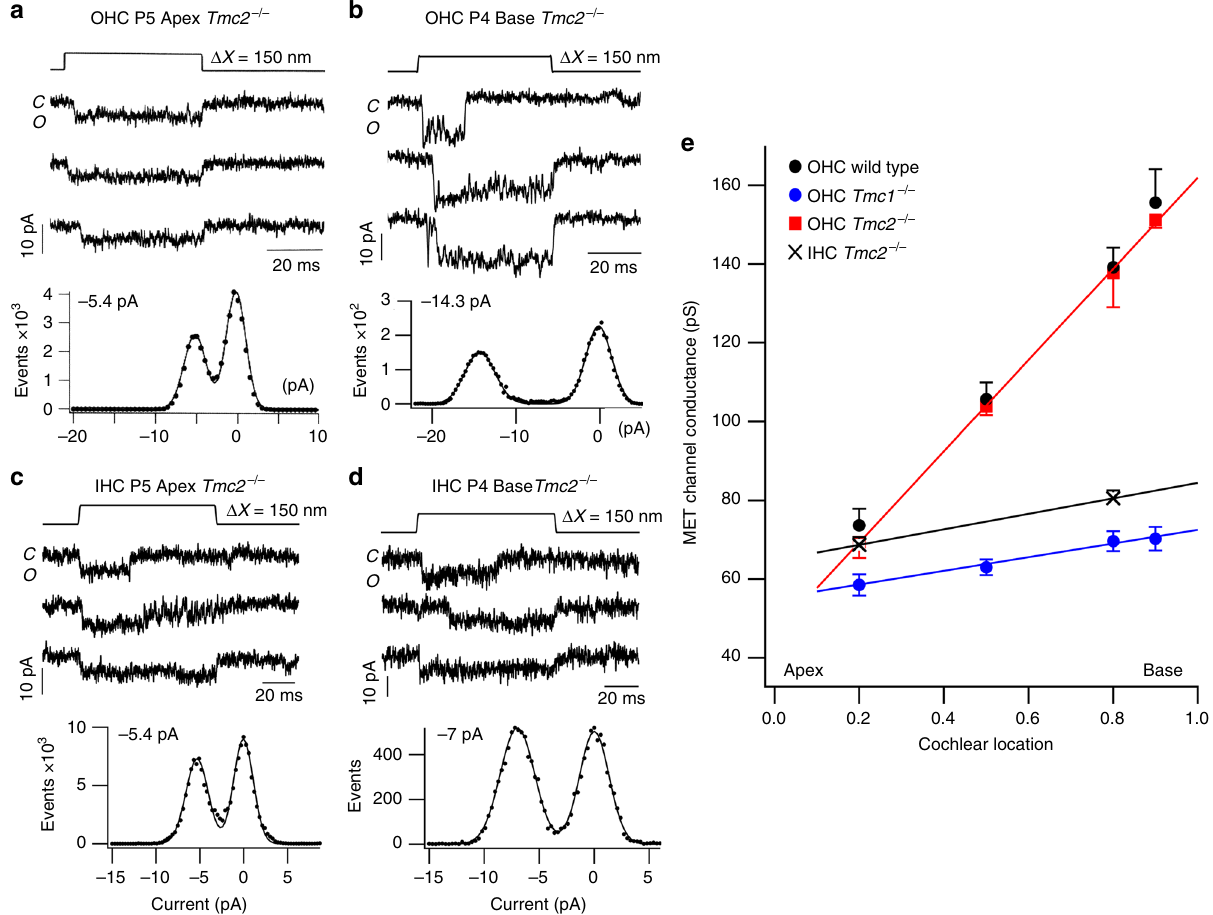
Fig. 2 Tonotopic organization of MET channels. a Three examples of single-channel currents in response to hair bundle de fl ection (top) in P5 apical Tmc2 − / − mice. Amplitude histogram of events gives − 5.4 pA single-channel current. b Three examples of single-channel currents in P4 basal OHC; amplitude histogram of events gives − 14.3 pA single-channel current. Holding potential − 84 mV. c Three examples of single-channel currents evoked in apical IHC of P5 Tmc2 − / − mice. Amplitude histogram of events gives 5.4 pA single-channel current. d Three examples of single-channel currents in P4 basal IHC; amplitude histogram of events gives 6.9 pA single-channel current. Holding potential − 84 mV. e Collected results on MET channel conductance plotted against fractional distance along the cochlea from the apex, for OHCs of P3 – P7 wild-type (black symbols), Tmc2 − / − mice (red symbols), and Tmc1 − / − mice (blue symbols) and for Tmc2 − / − mouse IHCs (black crosses). Each point is the mean ± SEM; numbers of cells, apex to base: OHC wild type, 14, 4,14, 7; OHC Tmc2 − / − 11, 4, 10, 3; OHC Tmc1 − / − 18, 3, 14, 3; IHC Tmc2 − / − 7, 5. Lines drawn through points for Tmc2 − / − and Tmc1 − / − mice. MET channels for Tmc2 − / − mice still exhibit a tonotopic conductance gradient like wild type, but the gradient is virtually absent in Tmc1 − / − mice indicating the tonotopic conductance gradient is supported by TMC1 but not TMC2. All measurements in 1.5 mM extracellular Ca 2